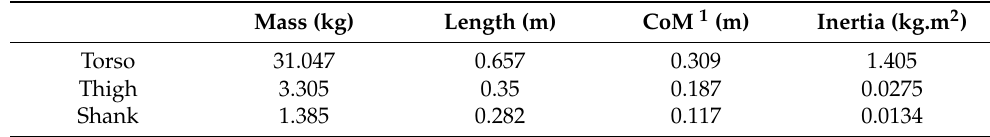
Table 1. Physical parameters of the biped model. Mass (kg) Length (m) CoM 1 (m) Inertia (kg.m 2 ) Torso 31.047 Thigh